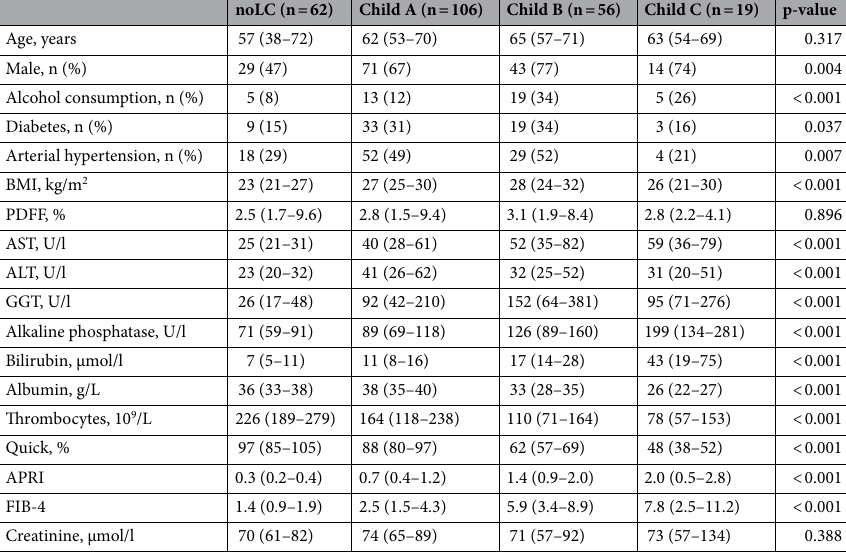
Table 1. Patient characteristics. Values are presented as median and interquartile range (25%-quartile–75%- quartile) or n (%). p-values are calculated using the Kruskal–Wallis test and X 2 -test, as appropriate. Alcohol consumption was defined as ≥ 2 alcoholic beverages per day for men and ≥ 1 alcoholic beverage per day for women or the presence of a history of abusive alcohol consumption. noLC: no liver cirrhosis; Child A, B, C: Child Pugh group A, B, C; BMI: body mass index; PDFF: proton density fat fraction; AST: aspartate aminotransferase; ALT: alanine aminotransferase; GGT: gamma-glutamyltransferase; APRI: aspartate aminotransferase-to-platelet ratio index; FIB-4: Fibrosis-4 Index.